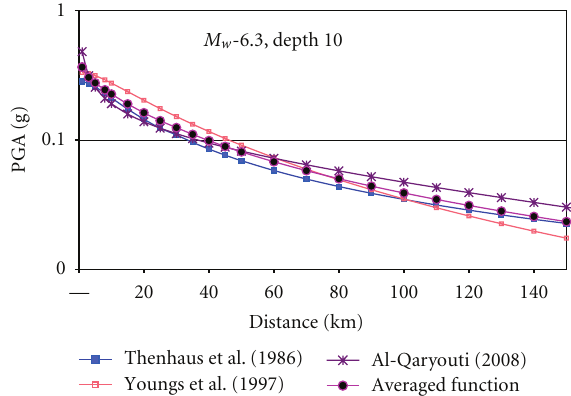
Figure 8: Hazard attenuation curves of PGA from three di ff erent studies [35, 36, 38] for an earthquake event of M w 6.5 and averaged curve used in the